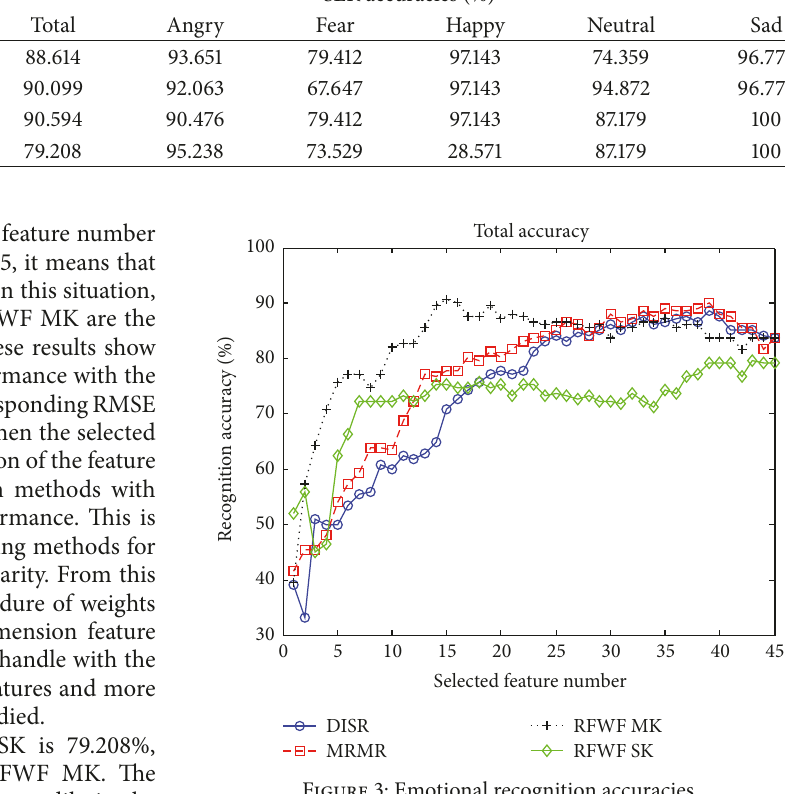
Table 3: Emotion recognition accuracies of different feature selection methods with the best feature number. Selection methods